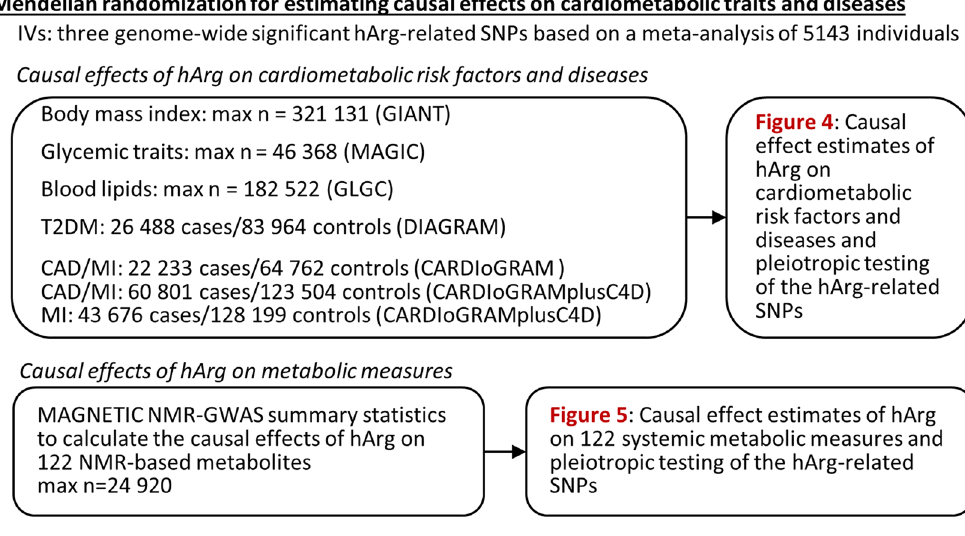
Figure 1. Overview of the study design, data sources and statistical